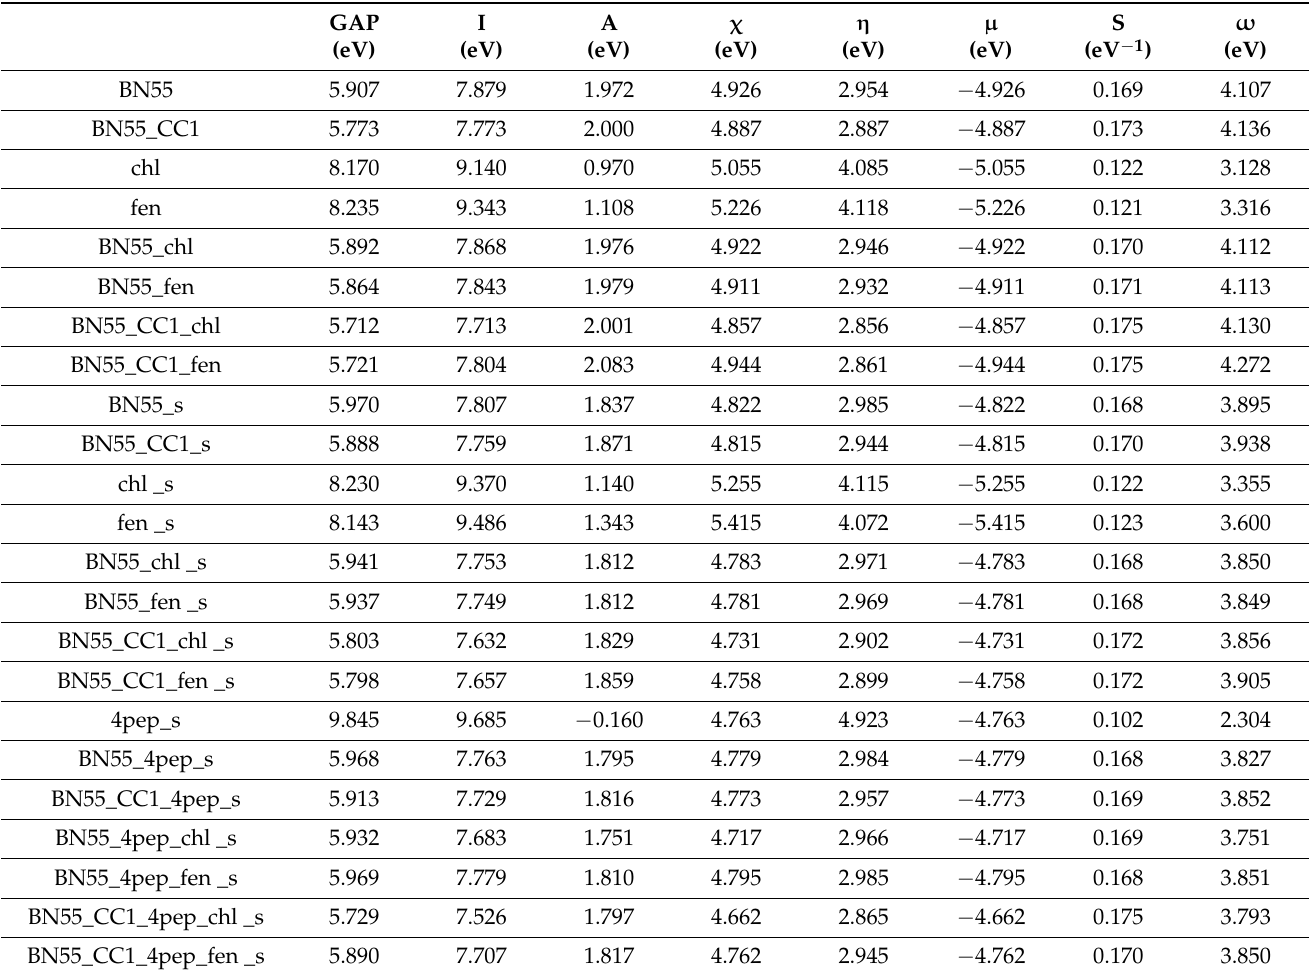
Table 2. The HSAB reactivity descriptors in the present